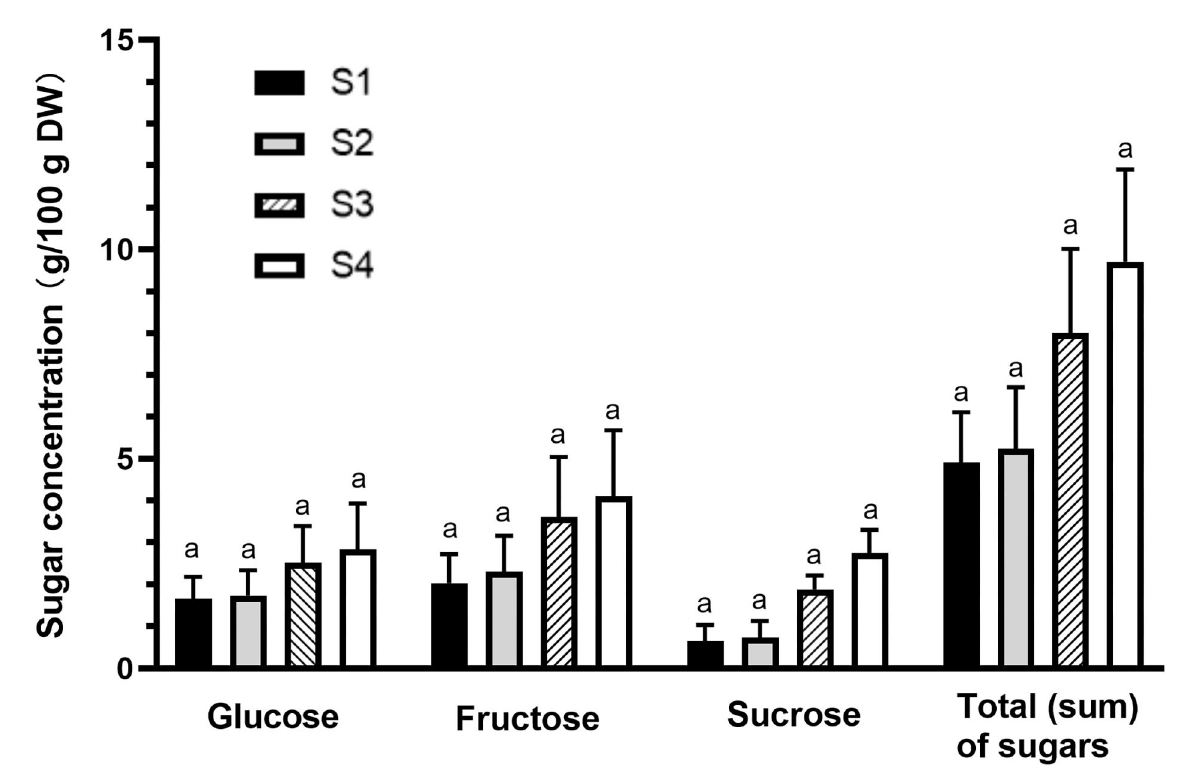
FIGURE5 Individual sugar components and total (sum) sugars of Kakadu plum fruit harvested at different maturity stages. Results are mean ± SE, n = 6. S1–4 denote the different maturity stages from immature (S1) to fully mature (S4). Different letters indicate the significant differences at p ≤ 0.05.